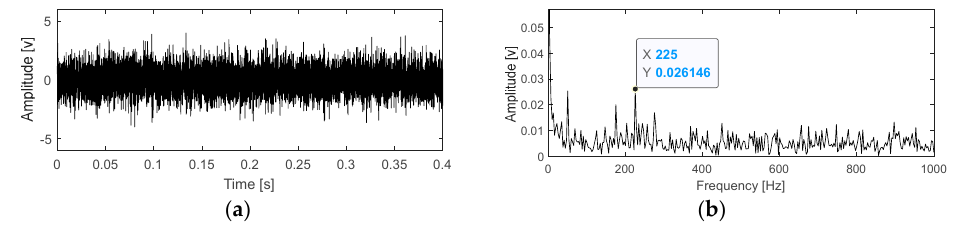
Figure 4. Timedomain waveform of the filtered simulated signal using cyclic Wiener filter with its envelope spectrum: ( a ) time domain waveform of the filtered signal as shown in Figure 3c using cyclic Wiener filter. ( b ) Envelope spectrum of the signal as shown in ( a ).